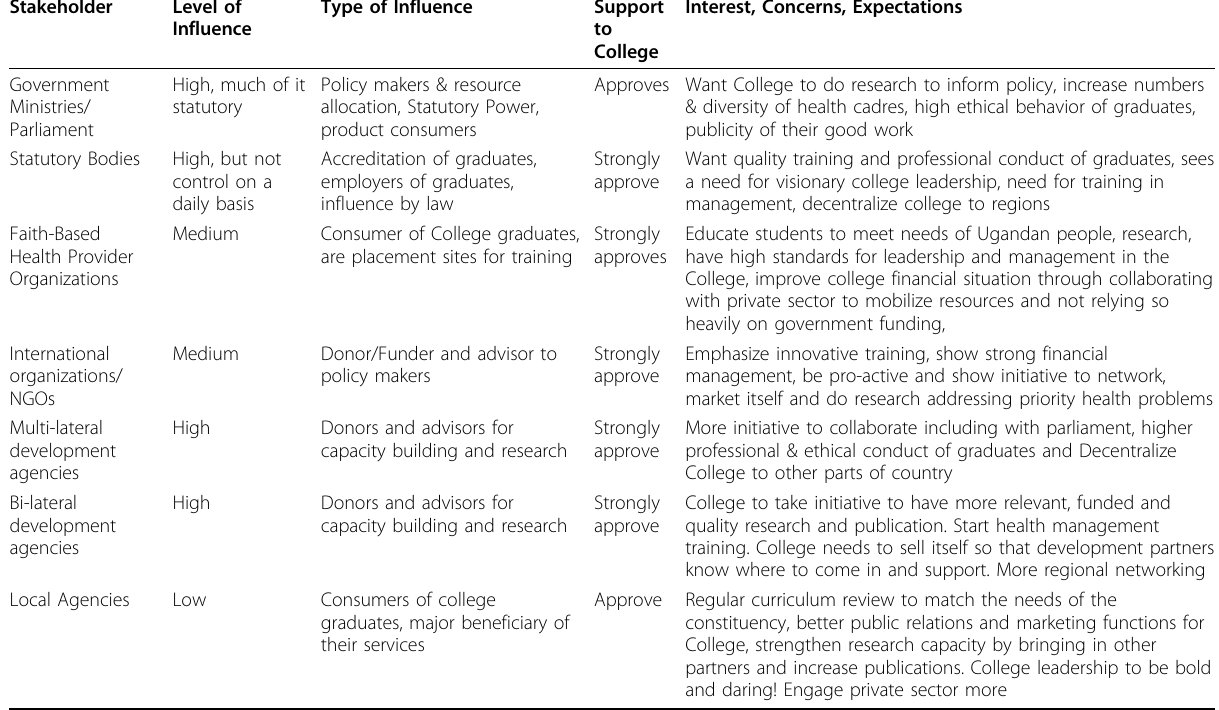
Table 1 Stakeholder characteristics and perspectives